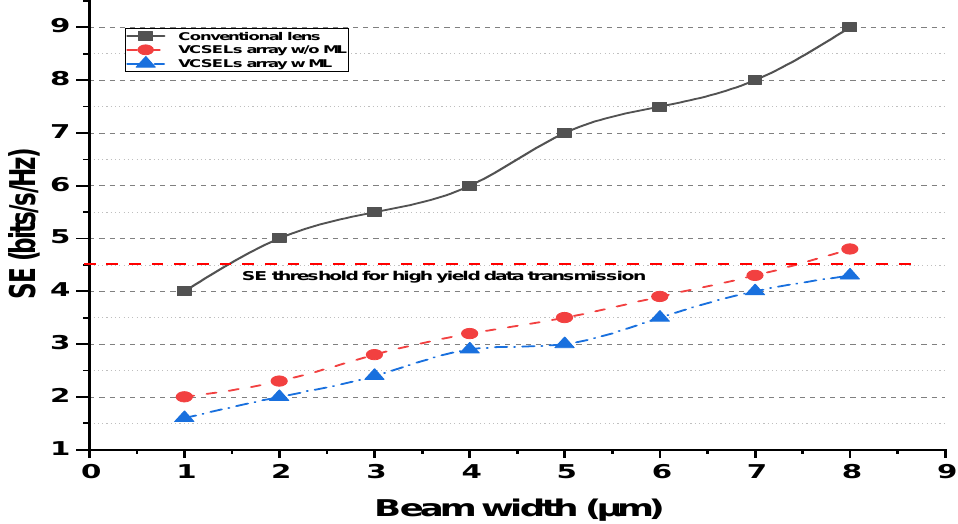
Figure 3. Spectral efficiency vs. beam-width analysis for the conventional laser, VCSEL using ML, and traditional